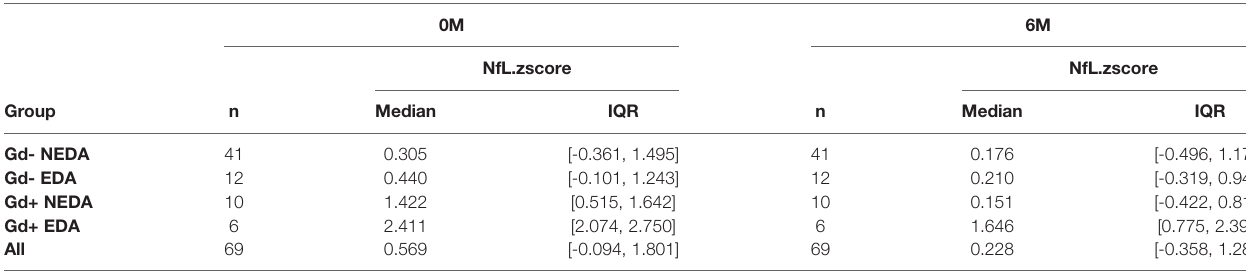
TABLE 2 | Cohort summary of age-normalized sNfL values.